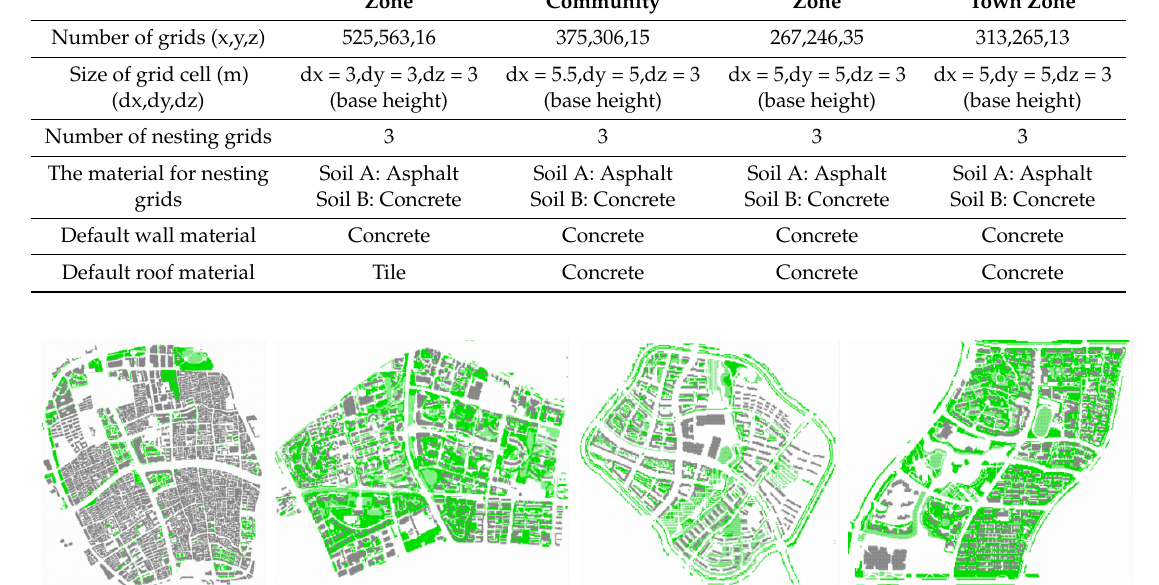
Figure 2. Modelling diagram of the four areas (From left to right: Old downtown zone, Gubei international community, Anting New Town zone, New Jiangwan Town zone).